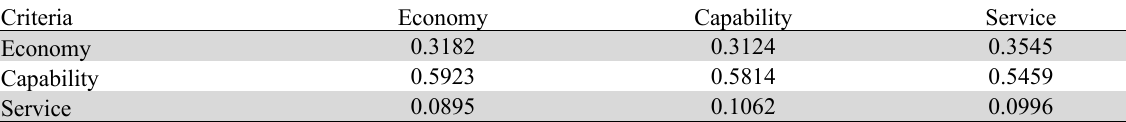
Normalized pairwise comparison matrix